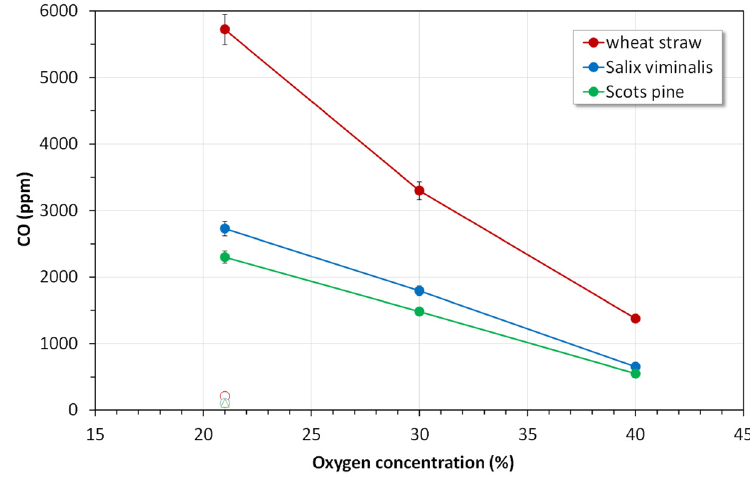
Figure 18. Influence of the oxygen concentration on total emissions of CO during combustion of biomass fuels. Open points represent combustion in air. Vertical bars represent standard deviation.